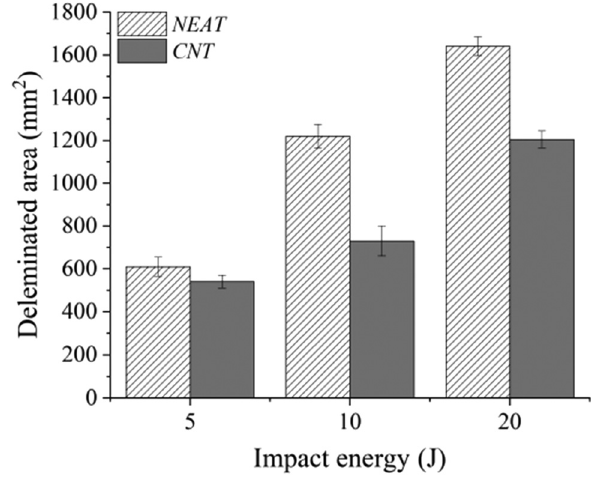
Figure 20: Impact test at 12 m/s on CNT - FRP composite plates with: ( a ) 0 wt% CNT, ( b ) 1 wt% CNT, ( c ) 2 wt% CNT, and ( d ) 4 wt% Figure 21: Delaminated area vs kinetic impact energy for neat and CNT fi lms laminates [ 112 ]